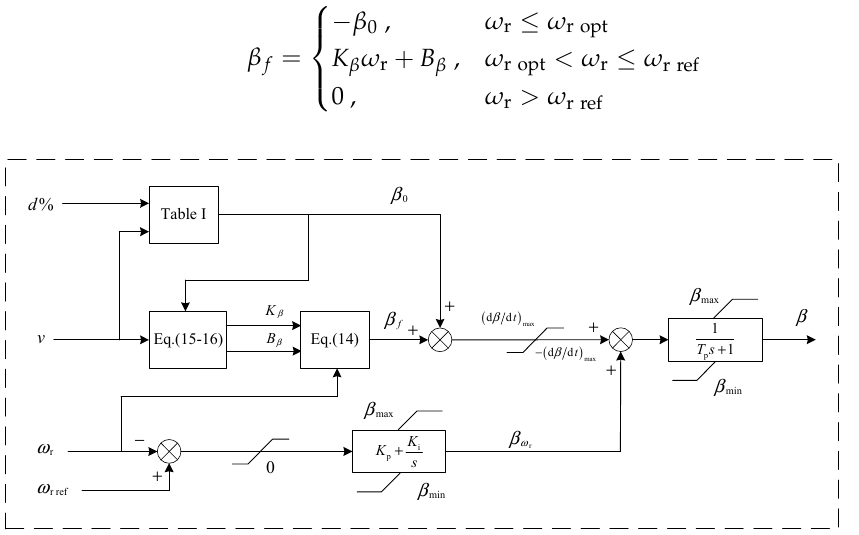
Figure 6. Configuration of DPAC.